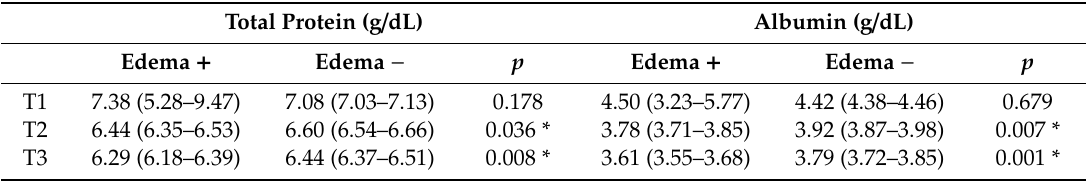
Table 4. Levels of plasma total protein and albumin dichotomized according to the appearance of edema in pregnant